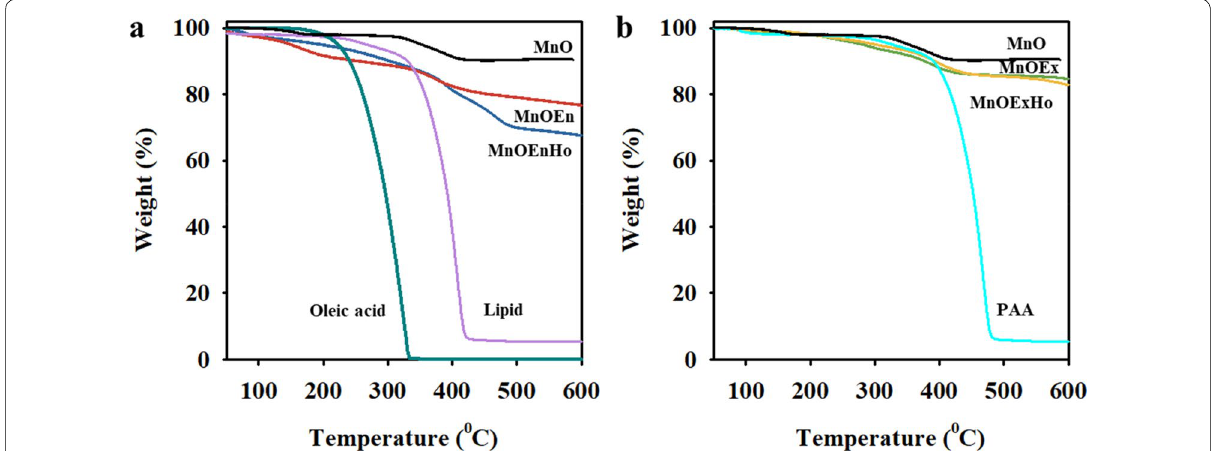
Fig. 4 TGA analysis of a MnO (black line), MnOEn (blue line), MnOEnHo (red line), oleic acid (cyan line) and lipid (light violet line), b MnO (black line), MnOEx (green line), MnOExHo (yellow line) and polyacrylic acid (PAA) (light blue